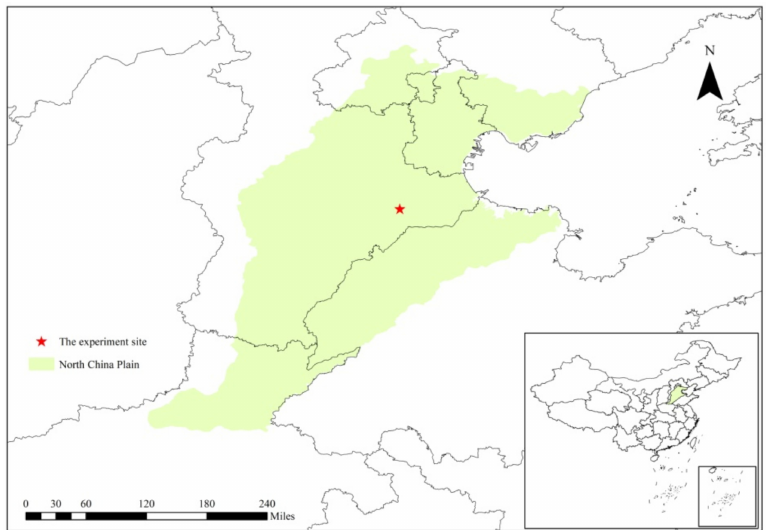
Figure 1. The location of study site in the North China